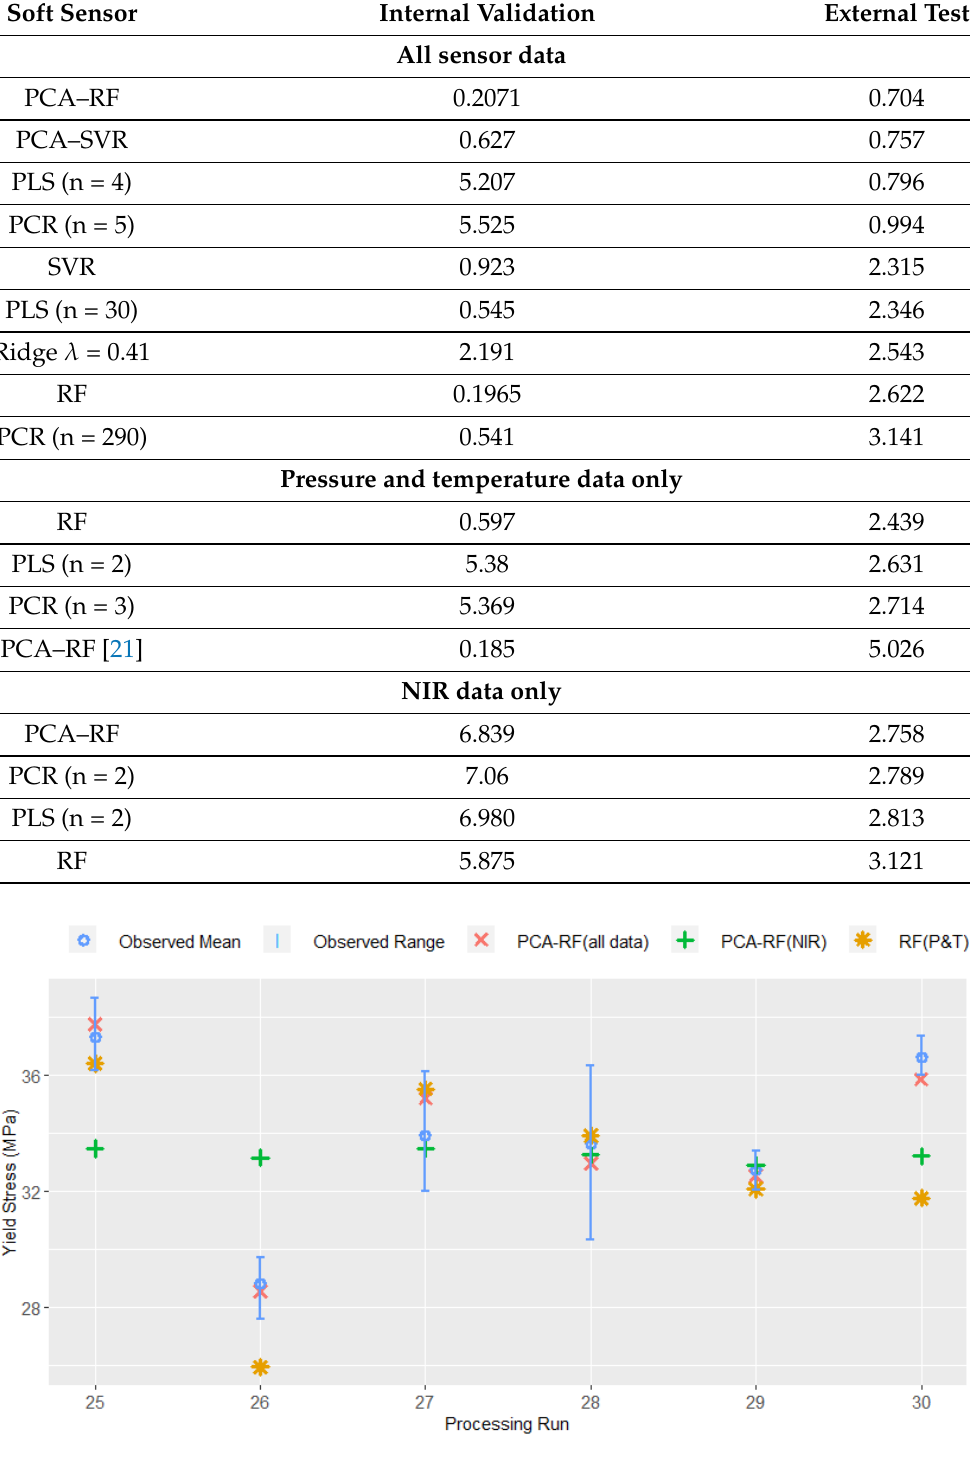
Figure 4. Comparison of predictions for external test set using: NIR and pressure and temperature data; pressure and temperature data only; and NIR data